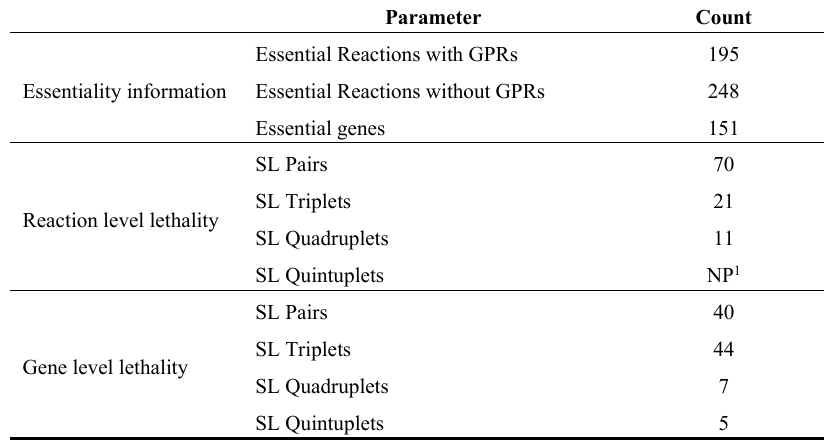
Table 1. Yeast 7.11 model statistics on Essentiality (ES) and Synthetic Lethality